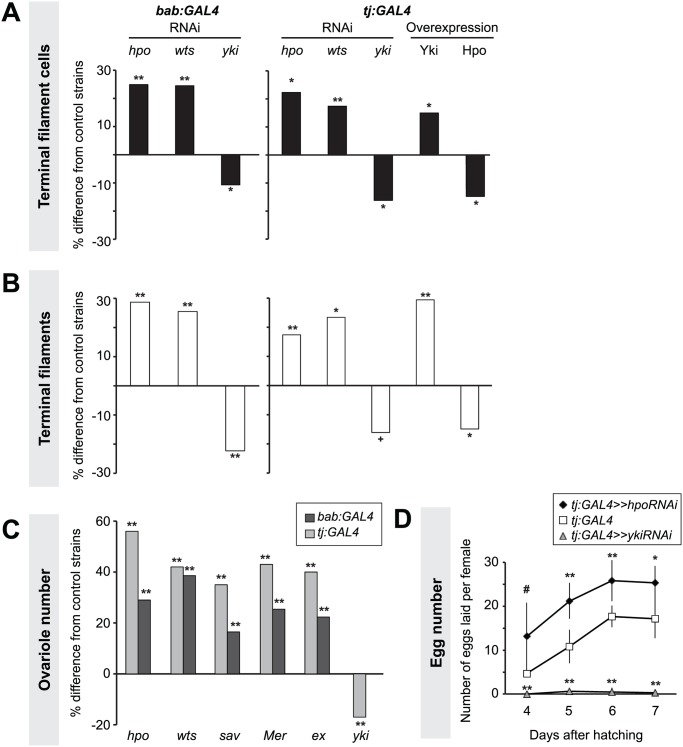
Hippo pathway influences proliferation of TFCs, thereby influencing ovariole number.Changes in (A) TFC or (B) TF number in LP ovaries expressing UAS-induced RNAi against hpo, wts or yki, or overexpressing hpo or yki under the bab:GAL4 or tj:GAL4 drivers. Here and in Figs. 3–6, S4 and S5, bar graphs show percent difference from control genotypes of the indicated cell type or structure in each of the experimental genotypes, which are those that carry both UAS and GAL4 constructs. Control genotypes are either parental strains or siblings carrying a balancer chromosome instead of the GAL4 construct (see Methods). When statistical comparisons were performed to parental strains, values from the two parental strains were averaged and percent difference from the average was plotted. Statistical significance was calculated using a student’s two-tailed t-test with unequal variance. ** p<0.01, * p<0.05, + p<0.01 against the UAS parental line and p = 0.08 against the GAL4 parental line. n = 10 for each genotype. Numerical data can be found in S1 Table. (C) Changes in adult ovariole number in individuals expressing hpo, wts, sav, Mer, ex or yki RNAi under bab:GAL4 (dark grey bars) or tj:GAL4 (light grey bars) drivers. ** p< 0.01 against controls. n = 20 for each genotype. (D) Average egg counts from females four to seven days after hatching of tj:GAL4 (control, white squares), tj:GAL4 driving hpo
RNAi (black diamonds), tj:GAL4 driving yki
RNAi (grey triangles). Error bars indicate confidence intervals. * p<0.05, ** p<0.01. n = 5 vials containing 3 females per vial.